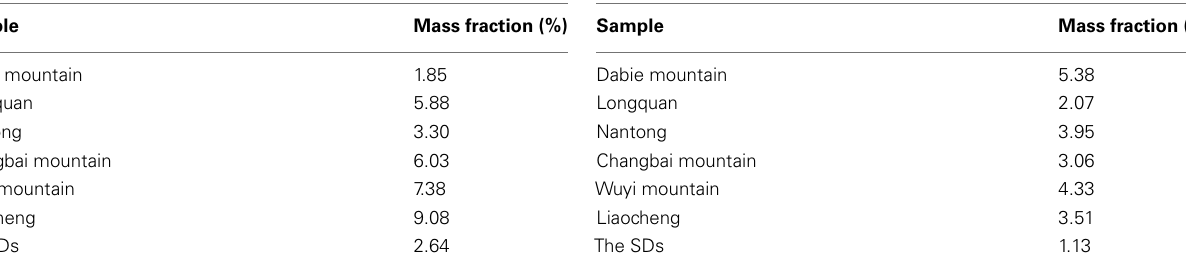
Table 4 | Polysaccharide content of Ganoderma lucidum in different regions.